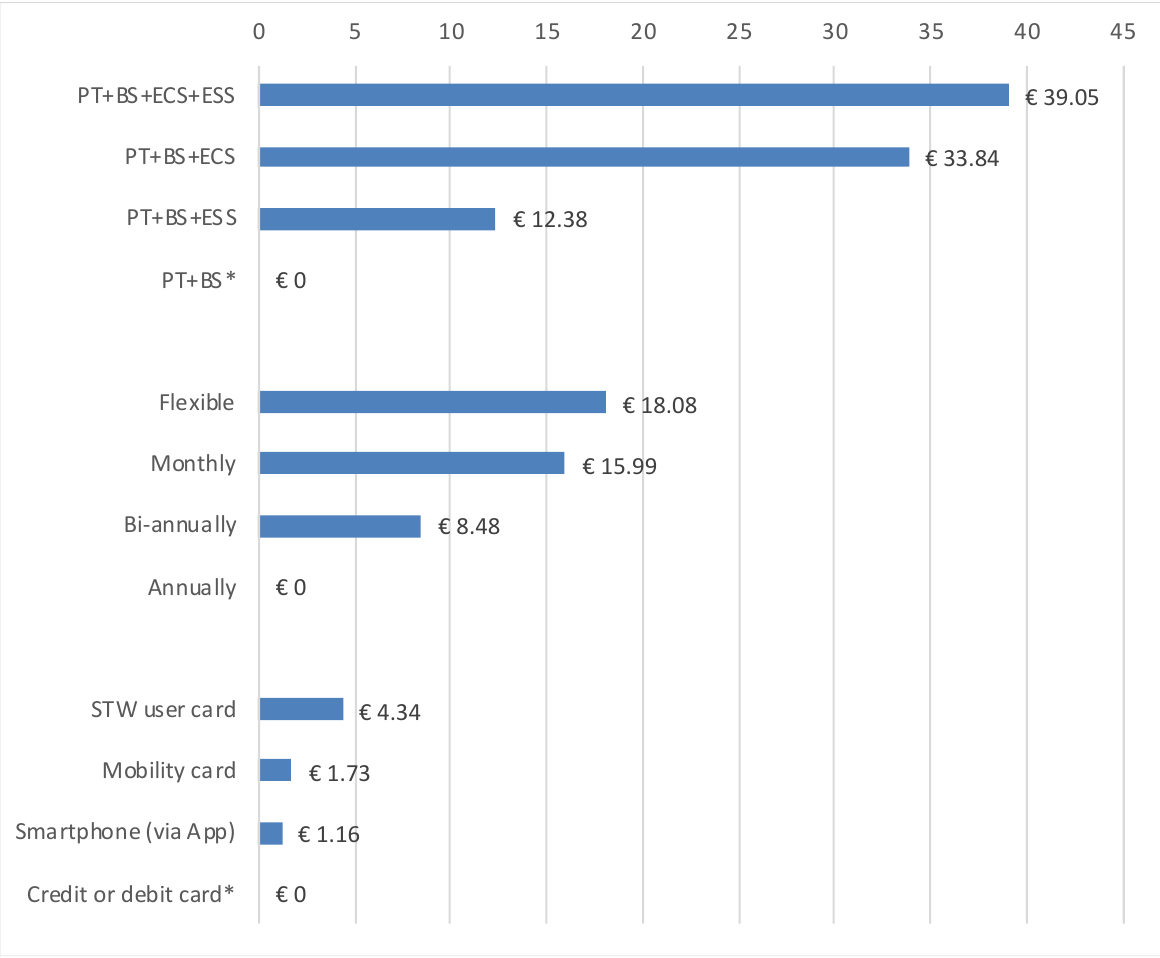
Figure 2. Indirect willingness to pay (WTP) for attribute levels of Mobility-as-a-Service (MaaS) packages (relative to default). Note: Bike sharing (BS), e-car sharing (ECS), e-scooter sharing (ESS), Stadtwerke Klagenfurt